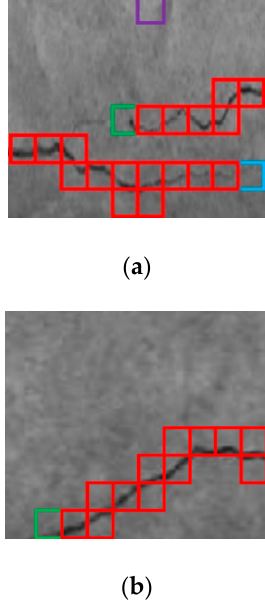
Figure 9. ( a ) Two separate cracks and ( b ) a continuous crack. The red box was the normal crack patch, and green and blue represent the left end and right end, respectively. Purple was an isolated crack patch; therefore, it was